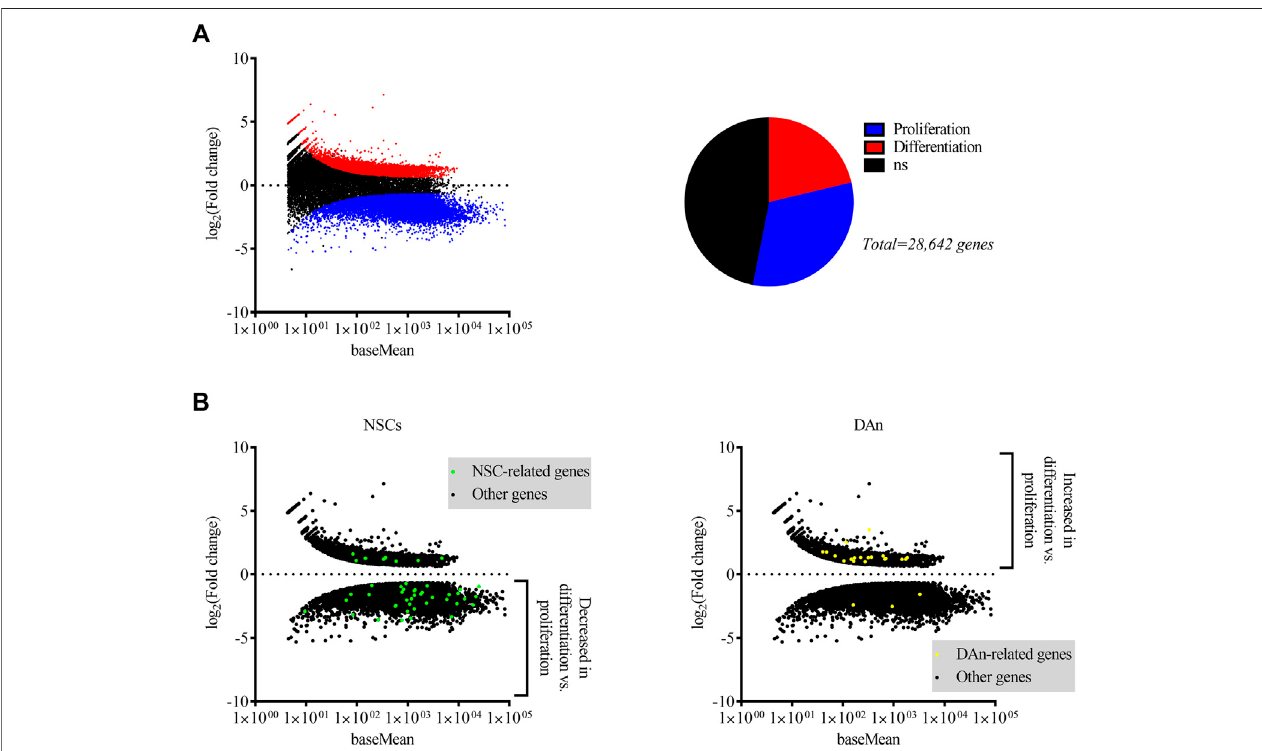
FIGURE1 | Differential expression ofgenesby dividing and differentiated hVM1 clone 32cells indicated upregulation ofNSC-associated genes inproliferation and of DAn-associated genes when differentiated. (A) MA plot (left) and pie chart (right) showing genes differentially expressed by hVM1 clone 32 cells in proliferation (blue dots and slice) and differentiation (red dots and slice) conditions. Black dots and slice indicate genes that had a non-signi fi cant q value (0.05 < q < 1). (B) MA plots representing NSC- ( left ; green dots) and DAn-related ( right ; yellow dots) differential gene expression. Black dots indicate differentially expressed genes not associatedwitheitherNSCs orDAn.NSC-related geneswereincreasedinproliferation, whilethoserelatedwithDAnwereincreasedindifferentiation. AllMAplots show the mean of normalized counts on the x -axis and log2 fold changes on the y -axis. All signi fi cantly differentially expressed genes had q < 0.05. Proliferation n (cid:1) 2, Differentiation n (cid:1) 2. Data were obtained from two independent